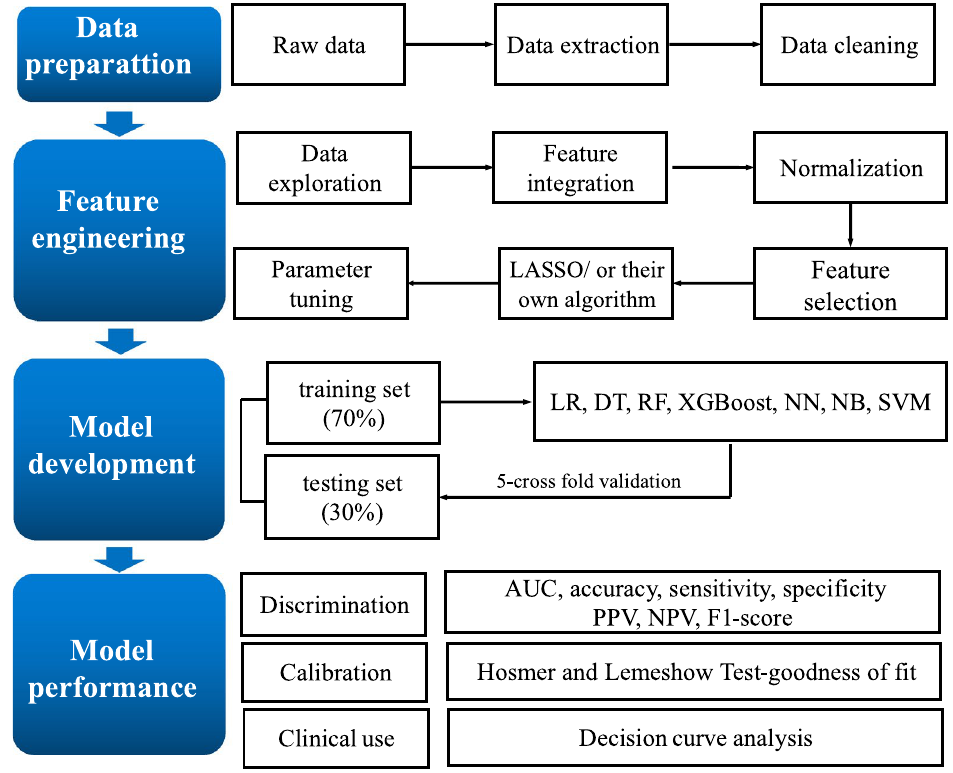
Figure 1. Flow chart of the probability analysis. LR logistic regression, DT decision tree, RF random forest, NN neural network, NB naïve bayes, SVM support vector machine, AUC area under the receiver operating characteristic curve, NPV negative predictive value, PPV positive predictive